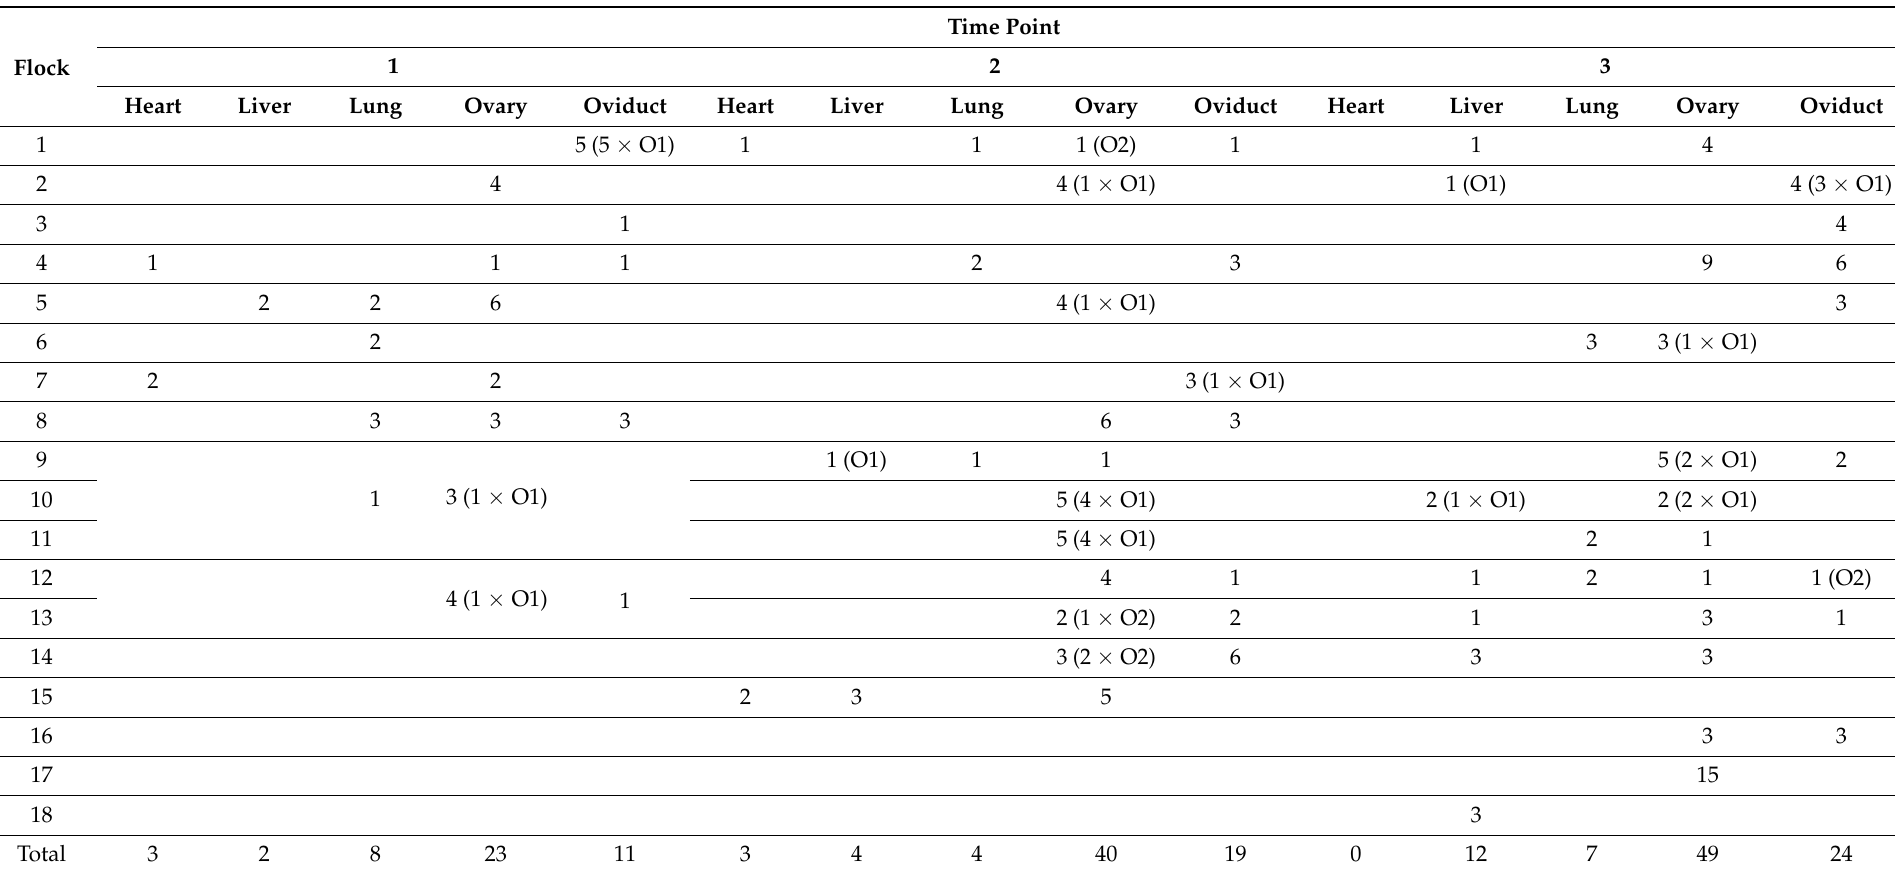
Table 2. Number of E. coli isolates per organ isolated at S1, S2, and S3, with corresponding serogroup in